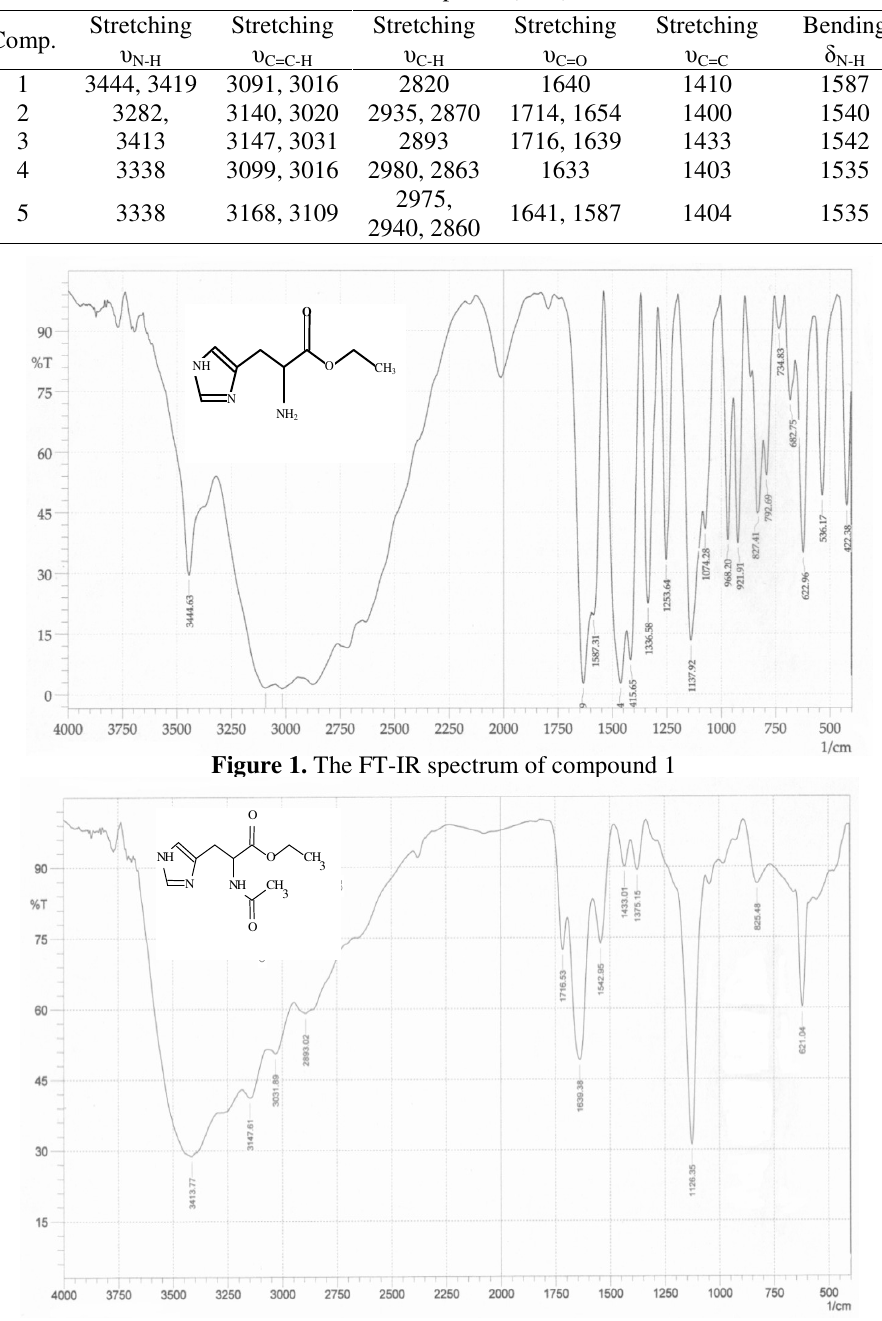
Figure 2. The FT-IR spectrum of compound